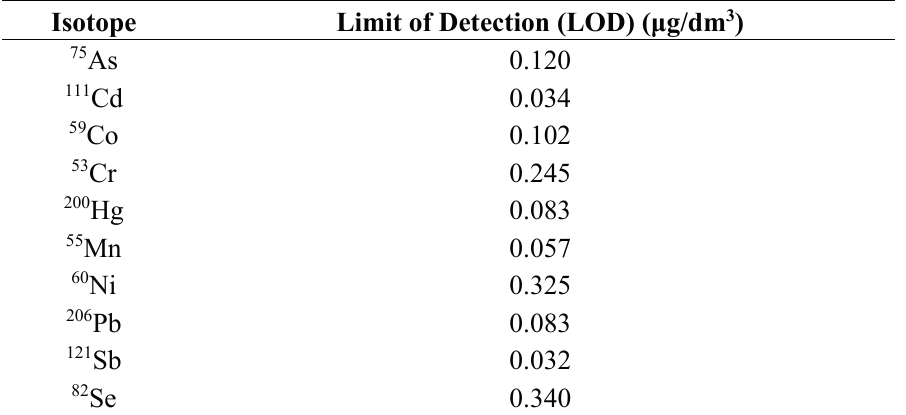
Table 2. The detection limits of the analysed elements obtained by inductively coupled plasma mass spectrometry (ICP